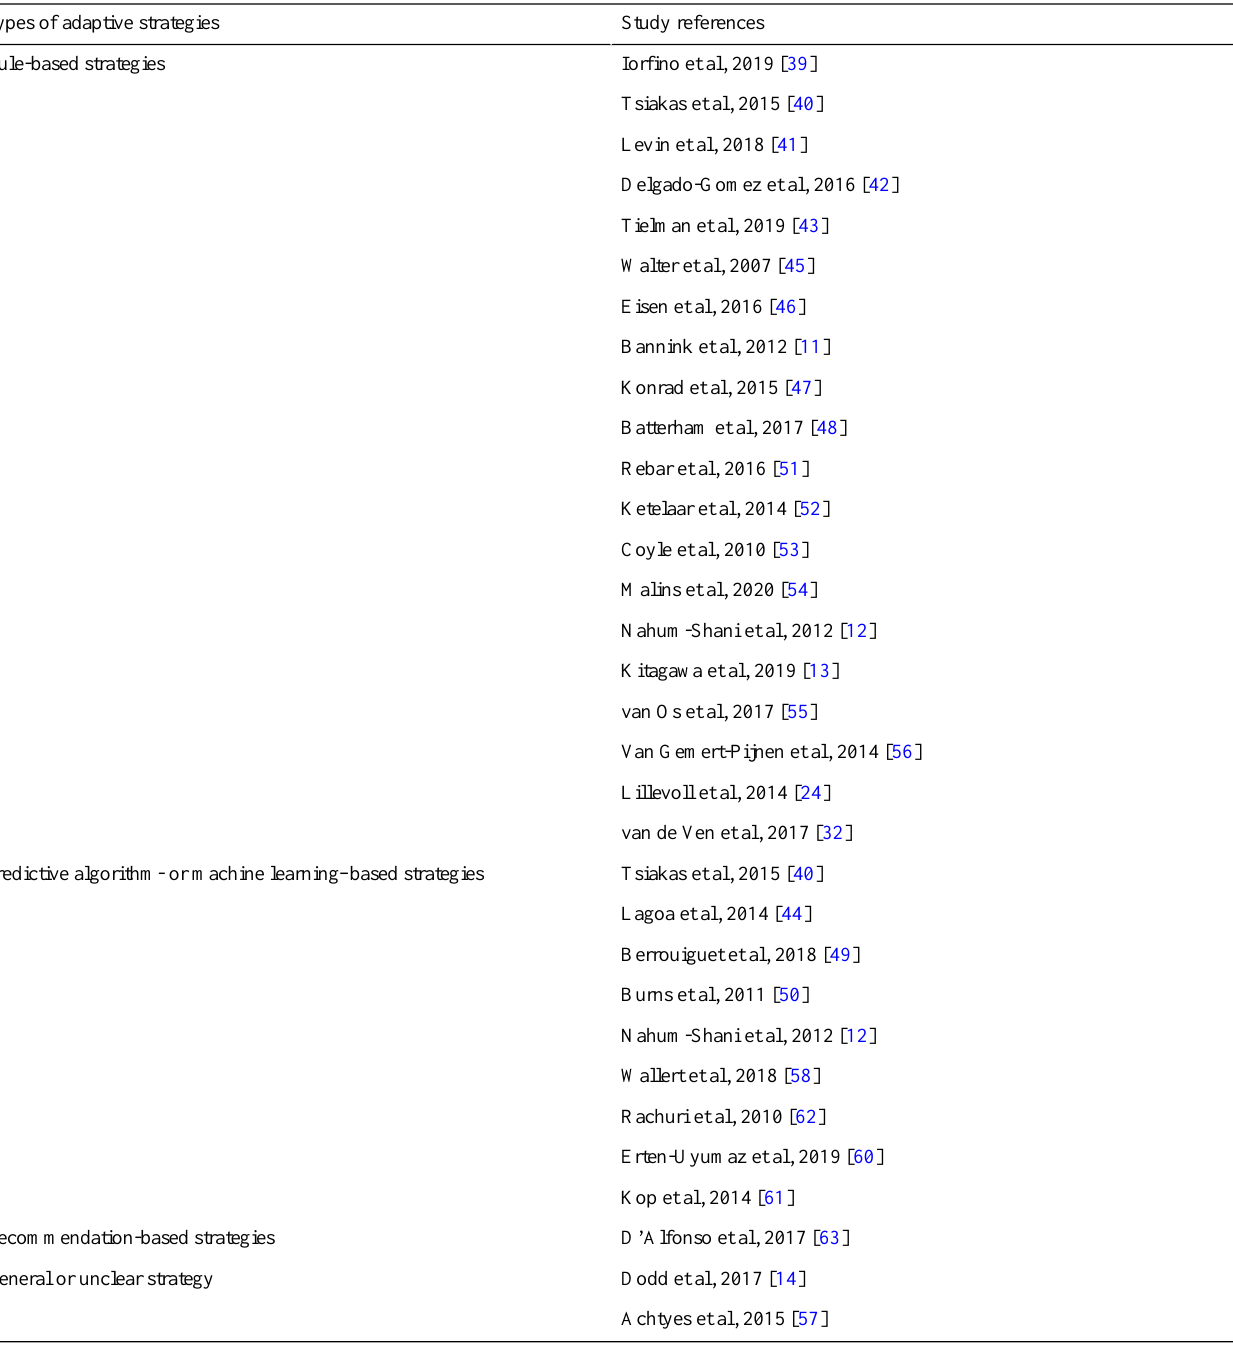
Table 5. Types of adaptive strategies found in the relevant